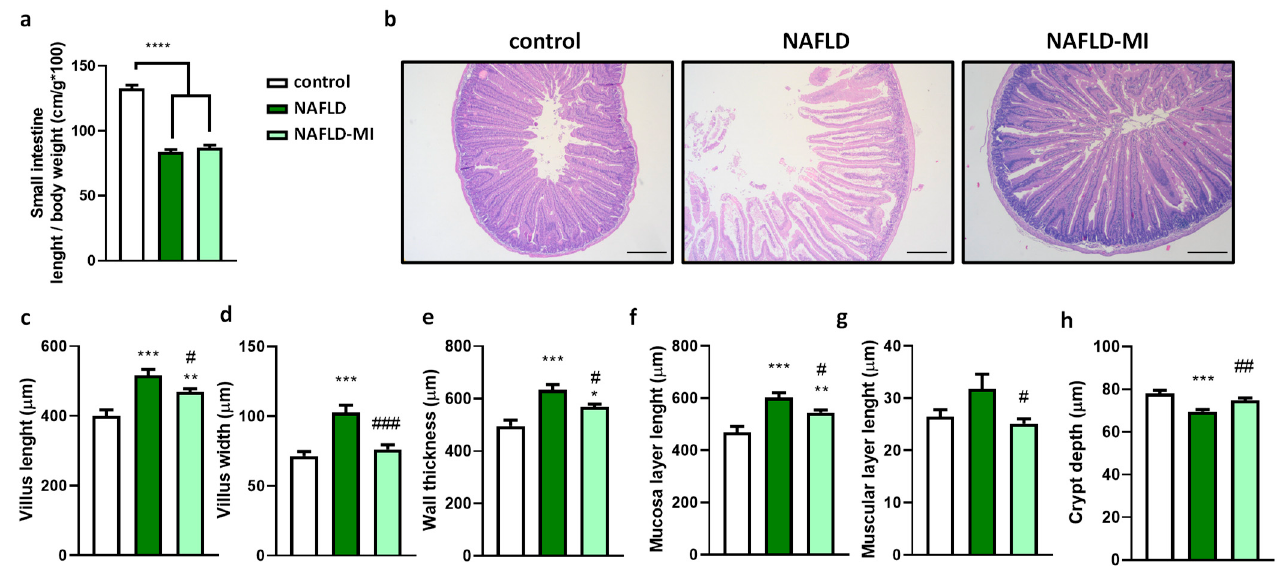
Figure 1. ( a ) Relative length of the small intestine of control, NAFLD, and NAFLD-MI groups. ( b ) Hematoxylin and eosin (H&E) staining of jejunums. Bar = 200 µm. Morphometric intestinal variables associated with NAFLD: ( c ) villus length, ( d ) villus width, ( e ) wall thickness, ( f ) mucosa layer length, ( g ) muscular layer length, and ( h ) crypt depth. Data are mean ± SEM. * p < 0.05 vs. control mice; ** p < 0.01 vs. control mice; *** p < 0.001; **** p < 0.0001 vs. control mice. # p < 0.05 vs. NAFLD mice; ## p < 0.01 vs. NAFLD mice; ### p < 0.001 vs. NAFLD mice.